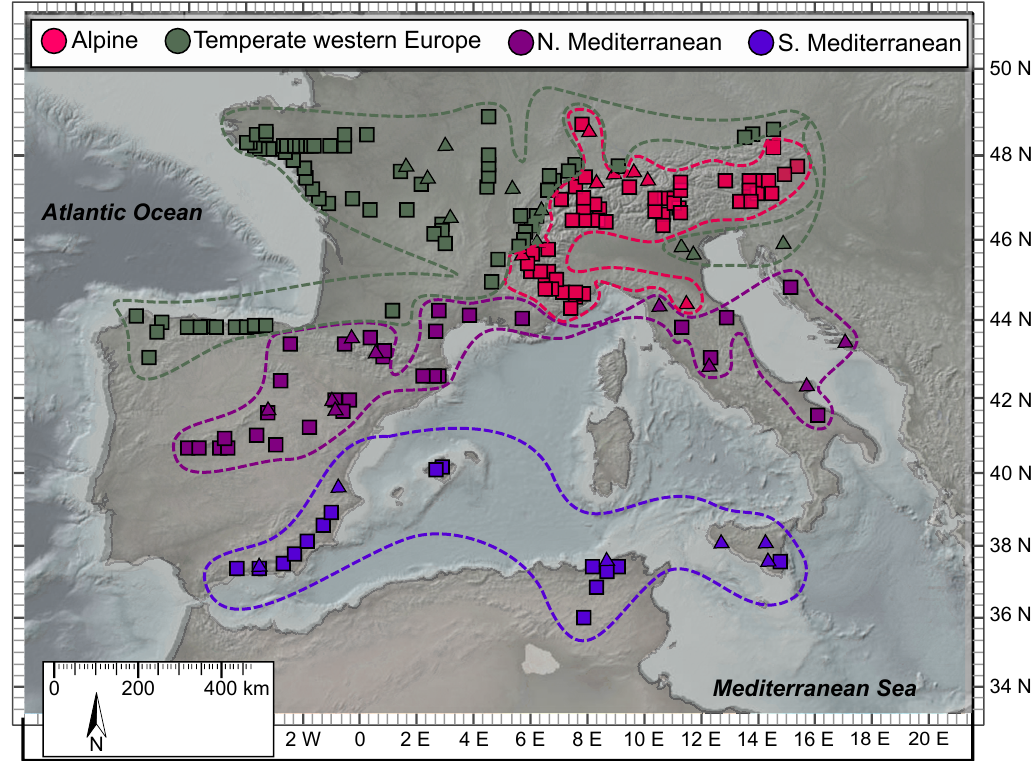
Figure 1. Western Mediterranean and Adjacent Atlantic Regions (WMAAR). The dashed lines show the approximate boundaries of the sub-regions identified with a classification tree. Squares and triangles depict the location of the sites employed in the vegetation and fire reconstructions, respectively (Table